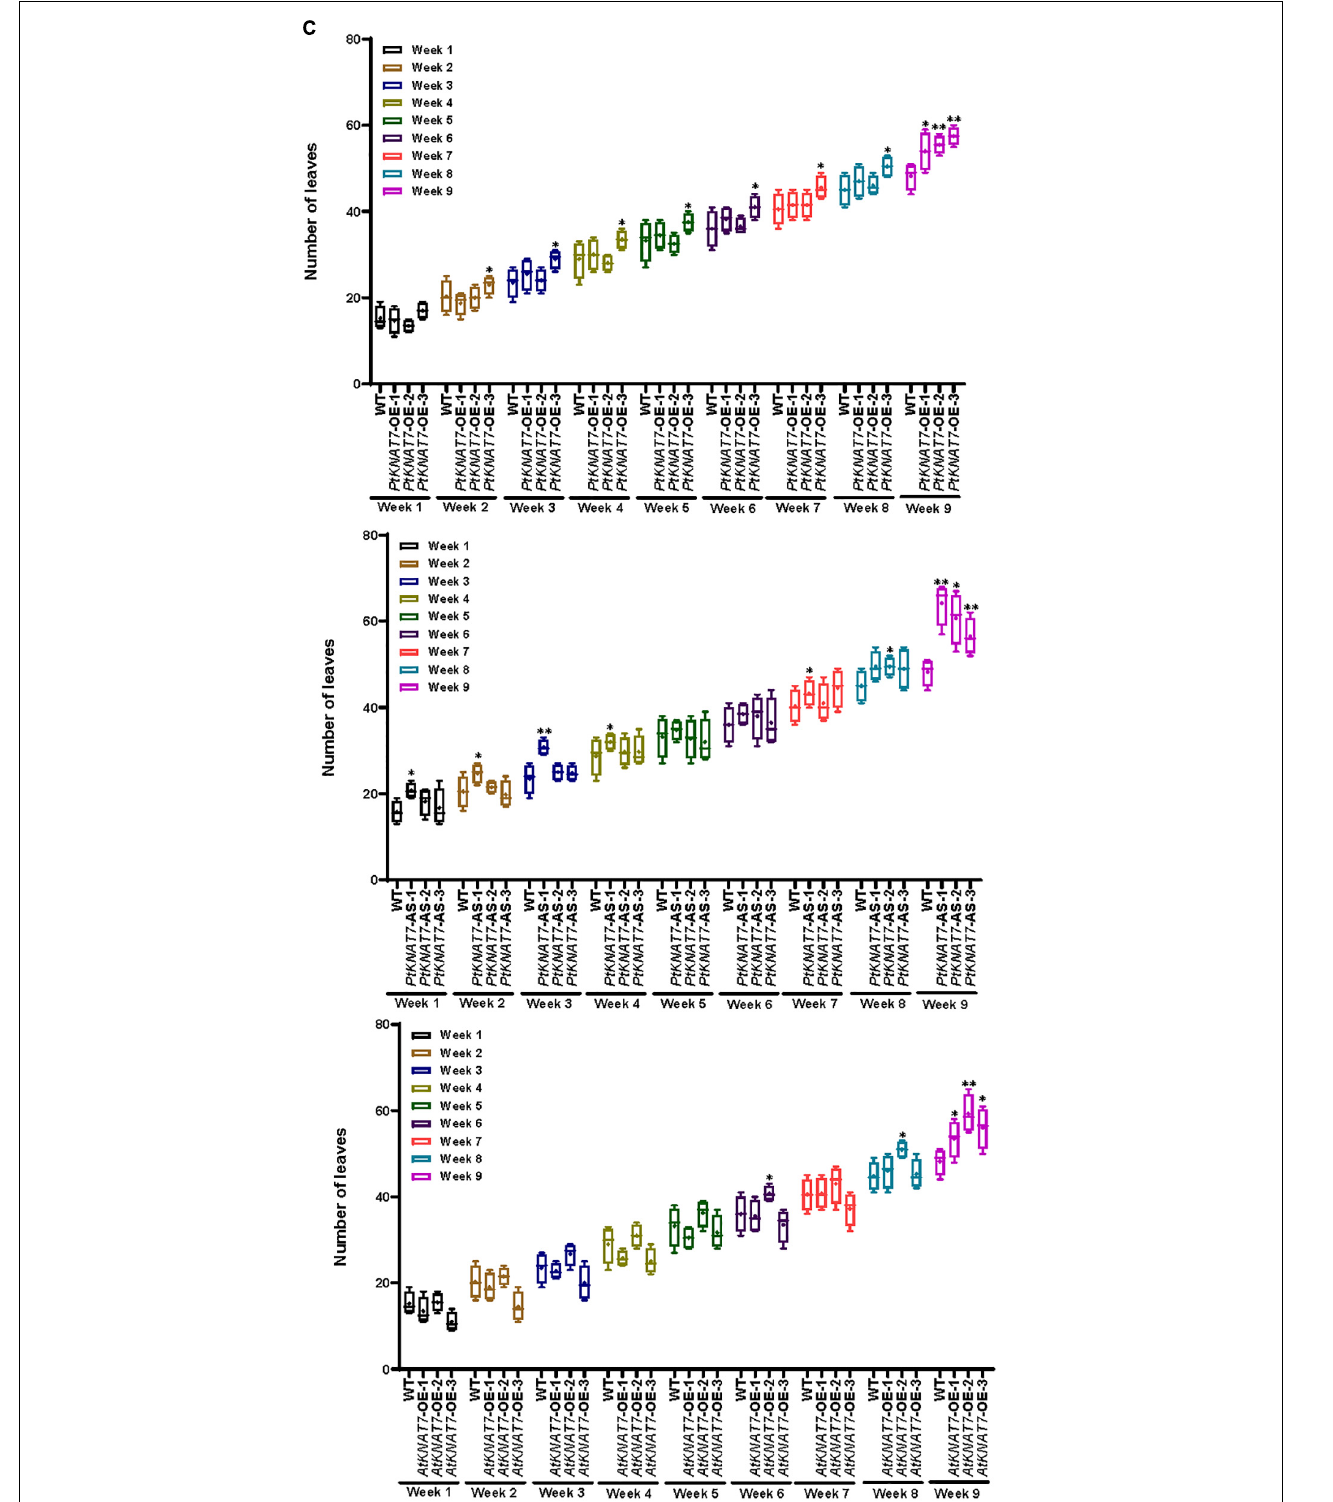
FIGURE 3 | Phenotypic measurements were performed every week in WT control and transgenic poplars until the day of harvest in the 9th week. (A) Plant Height, (B) stem thickness, and (C) the number of leaves in PtKNAT7 -OE, PtKNAT7 -AS, and AtKNAT7-OE were measured for 9 weeks until the day of harvest. The data is represented as a means ± SD ( n =